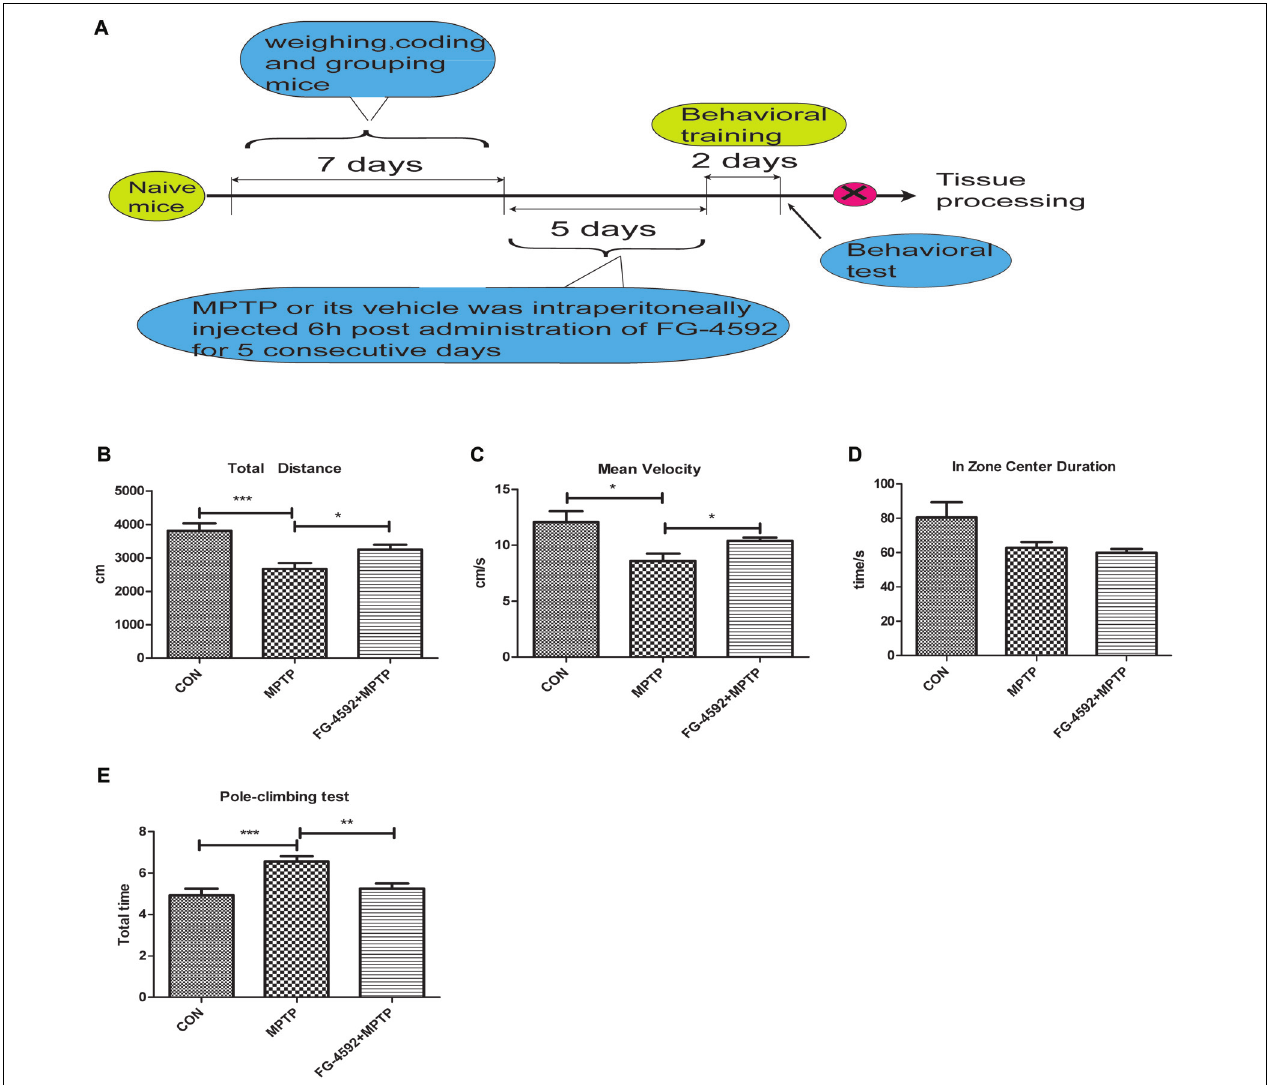
FIGURE 6 | FG-4592 reverses the behavioral impairments of MPTP-treated mice. A timeline detailing the coding, grouping, behavioral training, and time points for behavioral tests as well as drug treatments and tissue processing (A) . We studied the locomotor activity in MPTP-treated mice by open field test, and list the total distance, mean velocity and zone center duration (B–D) . We further evaluated MPTP-induced bradykinesia and coordination in mice by the pole test and list the total time in pole-climbing test (E) . Data were expressed as means ± SD, ∗ P < 0.05, ∗∗ P < 0.01, ∗∗∗ P < 0.001 as compared to control or MPTP treated group (each group n =